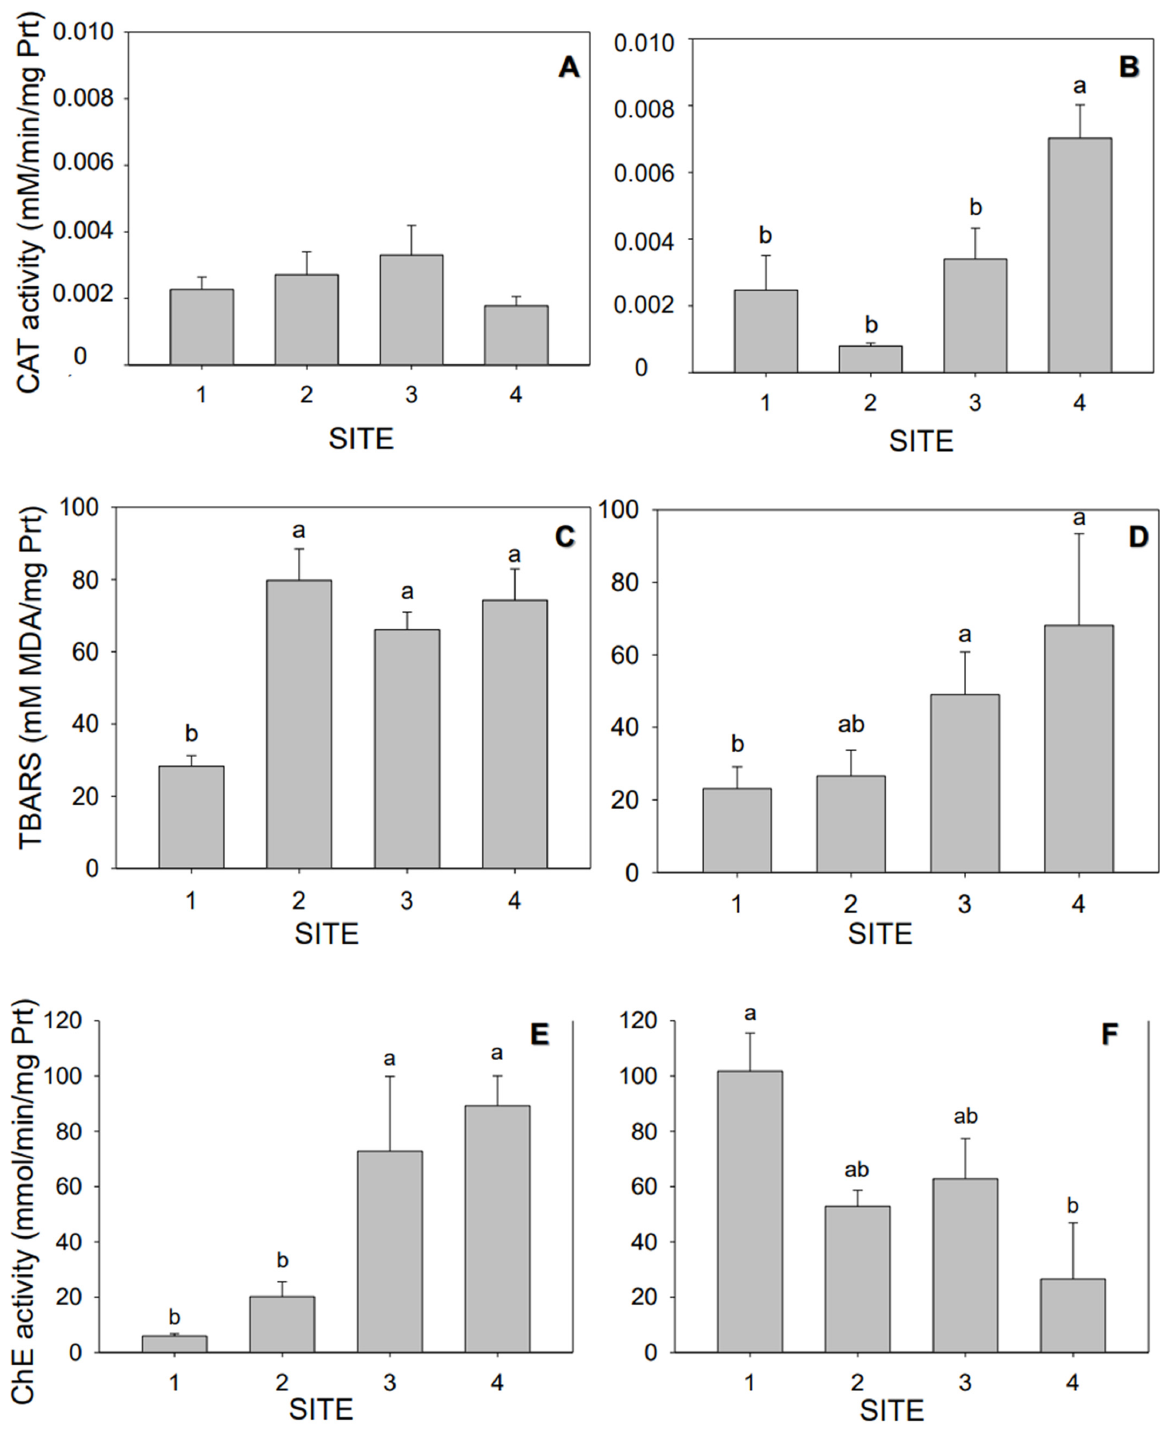
Figure 3. Biochemical endpoints measured in Jenynsia multidentata collected at the four study sites (S1 to S4), as catalase (CAT; ( A , B )), lipid peroxidation (TBARS; ( C , D )), and cholinesterase (ChE; ( E , F )) in the dry ( A , C , E ) and wet ( B , D , F ) seasons. Different letters indicate statistically significant differences among sampling sites ( p < 0.05). The whiskers represent the ±